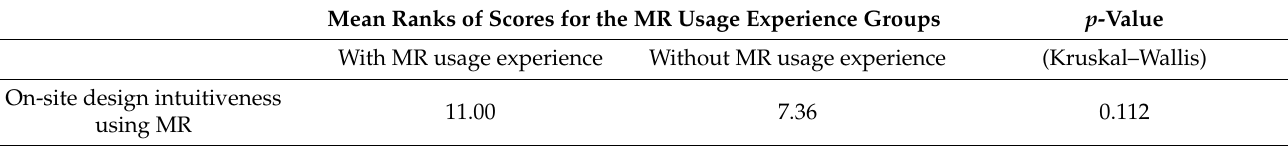
Table 2. The Kruskal–Wallis test for different design experience groups in on-site design intuitiveness using MR. Mean Ranks of Scores for the MR Design Experience Groups